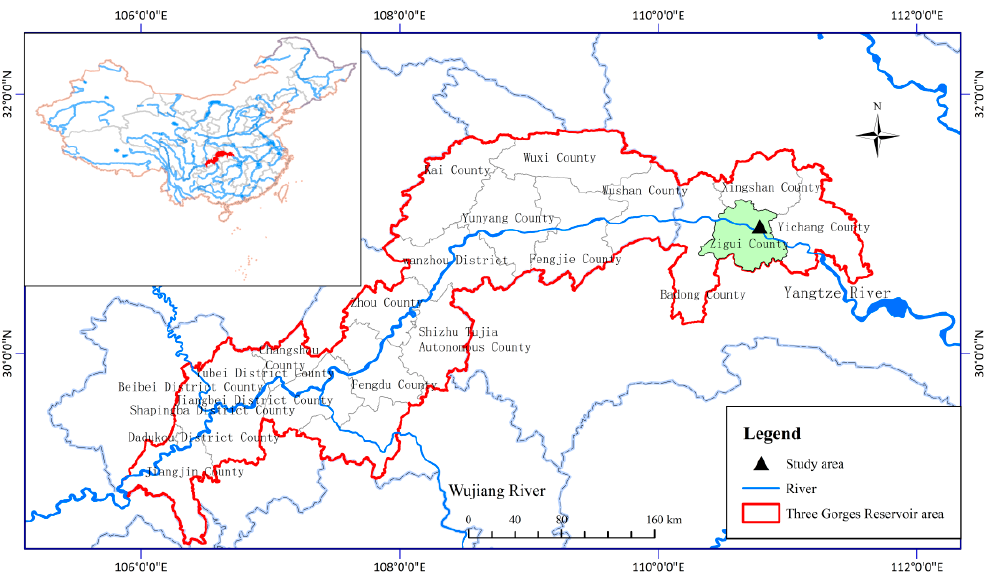
Figure 1. Location of the study area. The study area is indicated by a triangle, and Zigui County is marked in green. The Yangtze River (blue line) flows through the Three Gorges Reservoir area (red line).